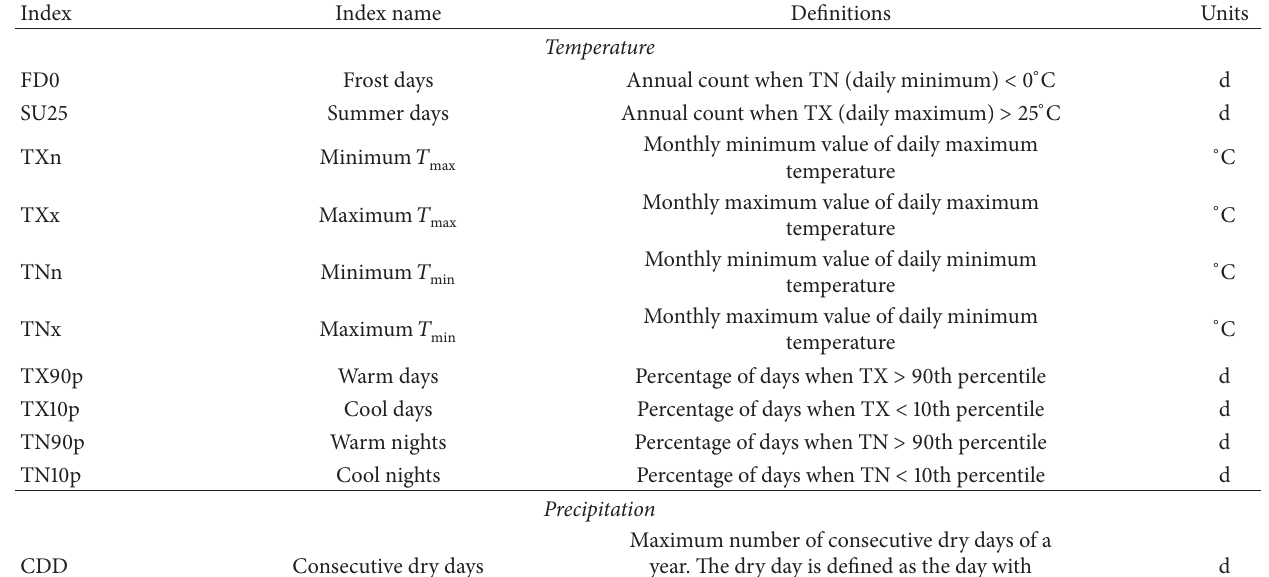
Table 2: Definitions of temperature and precipitation extreme indices used in the present